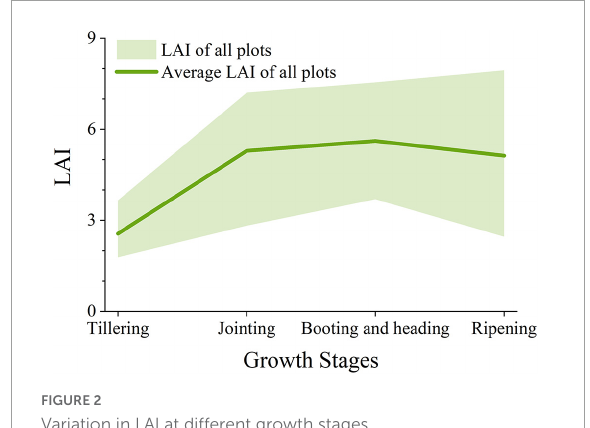
FIGURE2 Variation in LAI at different growth